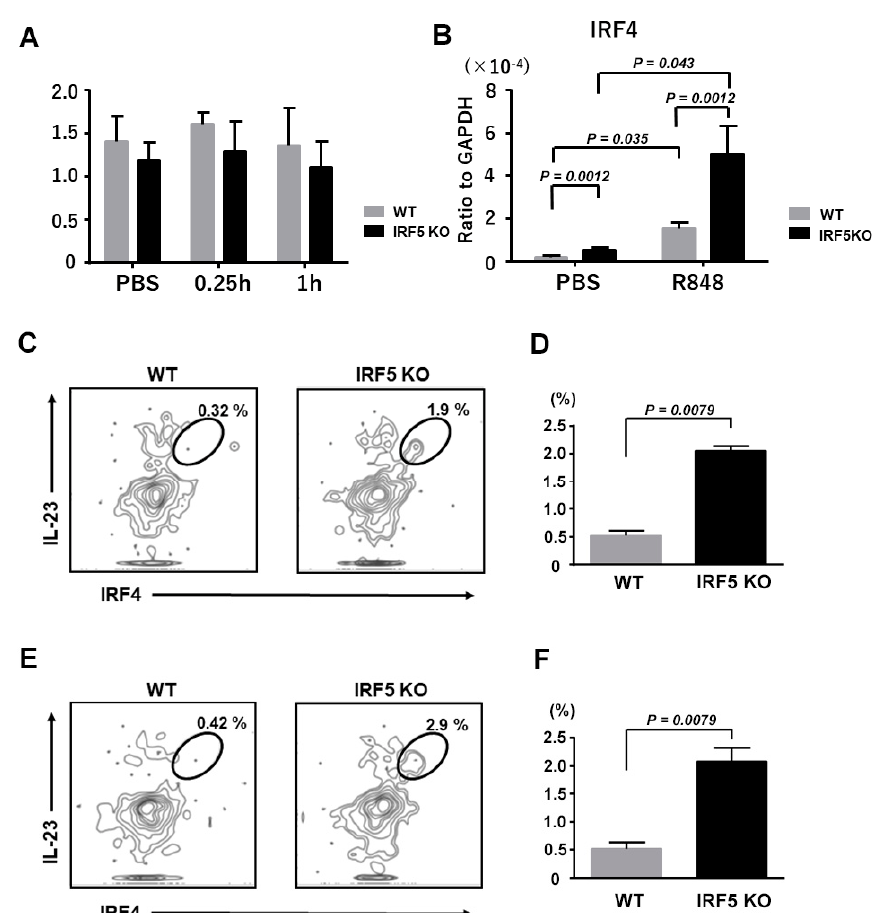
Figure 5. IRF4 expression levels were upregulated in dendritic cells from the IRF5-deficient mice. ( A ) Phosphorylated NF- κ B p65 expression in DCs stimulated with PBS or 1 µ g / mL R848 for a quarter of an hour or one hour was measured. ( B ) IRF4 mRNA expression levels in DCs before and after stimulation with 1 µ g / mL R848 for 24 h were determined by quantitative RT-PCR. Data are obtained from duplicate samples from 12 mice in each group. Values are presented as the mean ± SEM of three independent experiments. ( C , E ) Representative flowcytometryplots of IRF4 + IL-23 + DCs before ( C ) and after ( E ) stimulation with 1 µ g / mL R848 for 3 h. ( D , F ) The frequency of IRF4 + IL-23 + DCs before ( D ) and after ( F ) stimulation with 1 µ g / mL R848 for 3 h. Data are obtained from 5 mice in each group. Values are presented as mean the ± SEM of two independent